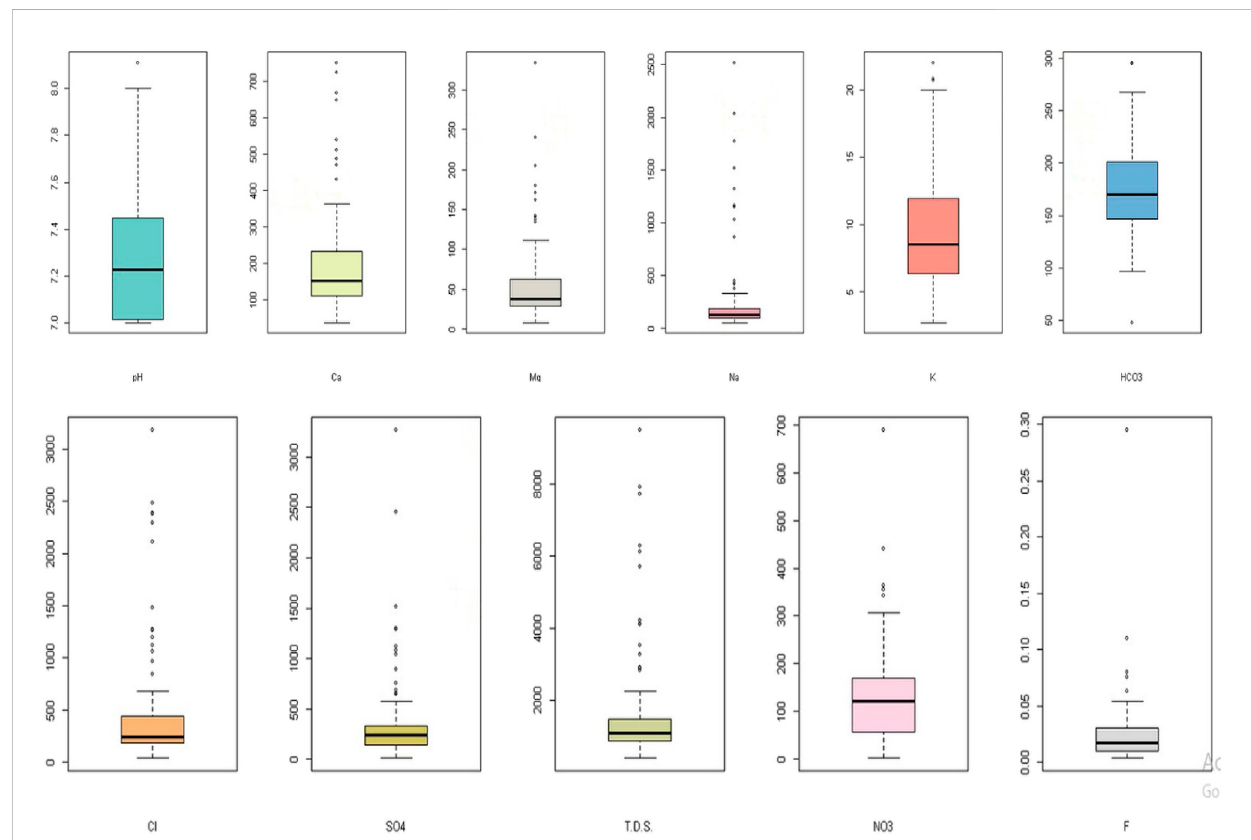
FIGURE 3 Box diagram of all parameter concentrations in